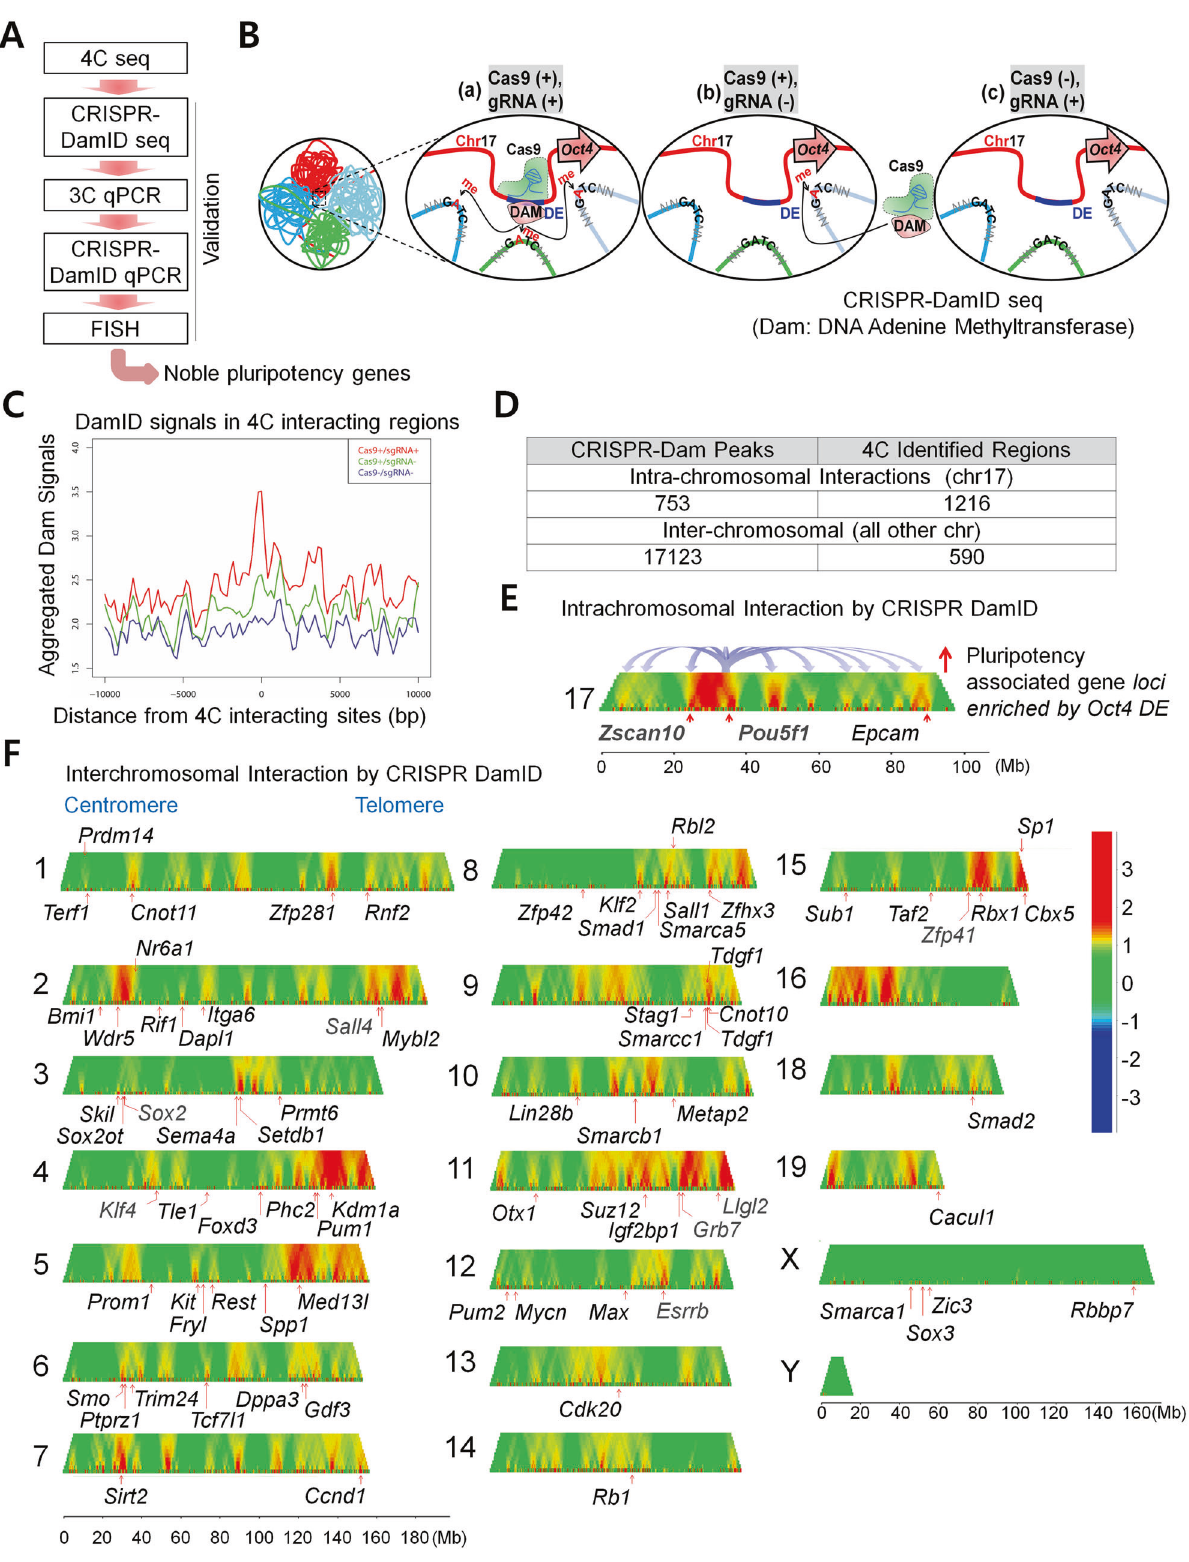
promoters of Llgl2 (Supplementary Fig. 3A – C) and a clear interaction signal at the Grb7 locus (Supplementary Fig. 3D – F). We also performed 3C-qPCR analysis to con fi rm our results (Fig. 2A). These interactions were further validated by our CRISPR-DamID